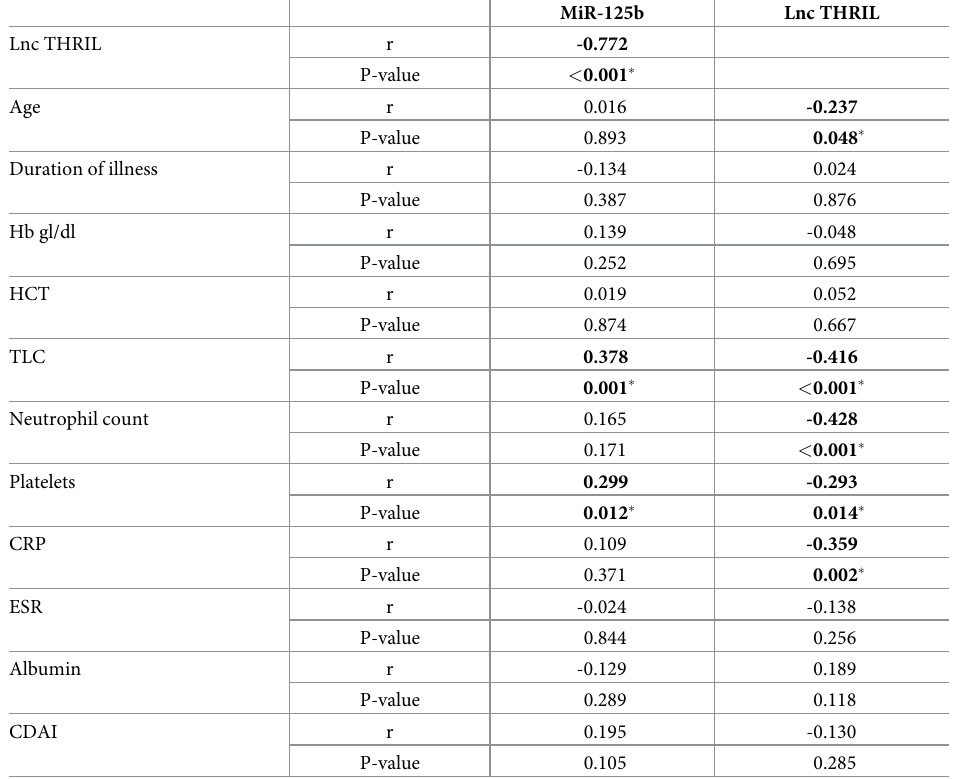
Table 6. Correlations of Lnc THRIL and MiR 125b with study parameters among CD patients.